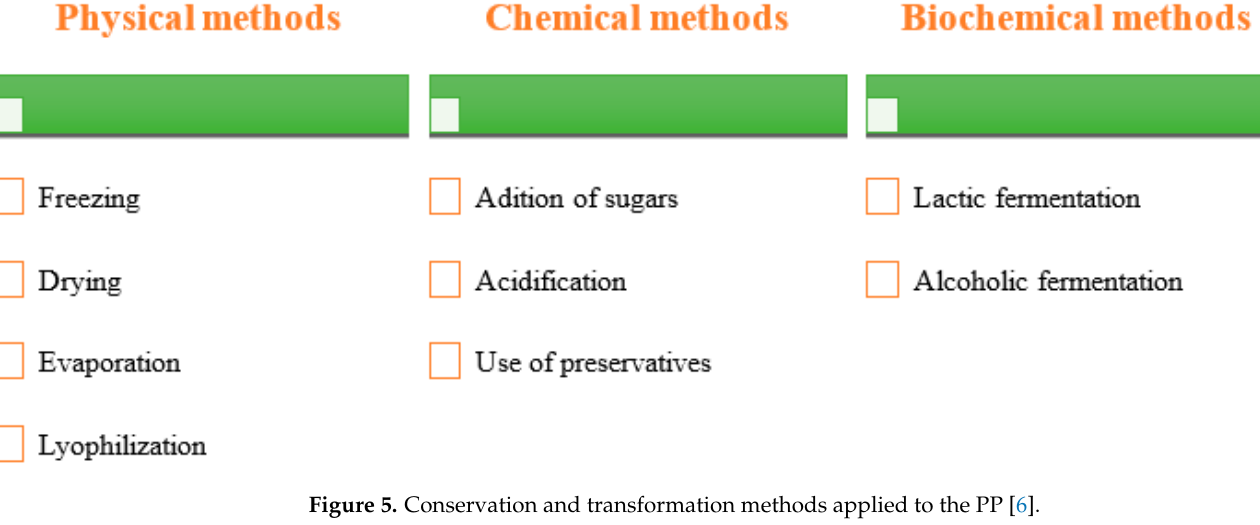
Figure 5. Conservation and transformation methods applied to the PP [6].